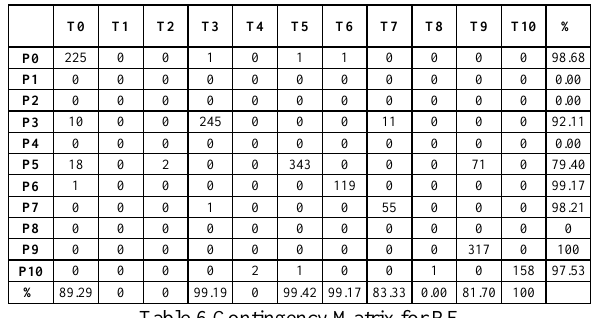
Table 6 Contingency Matrix for RF